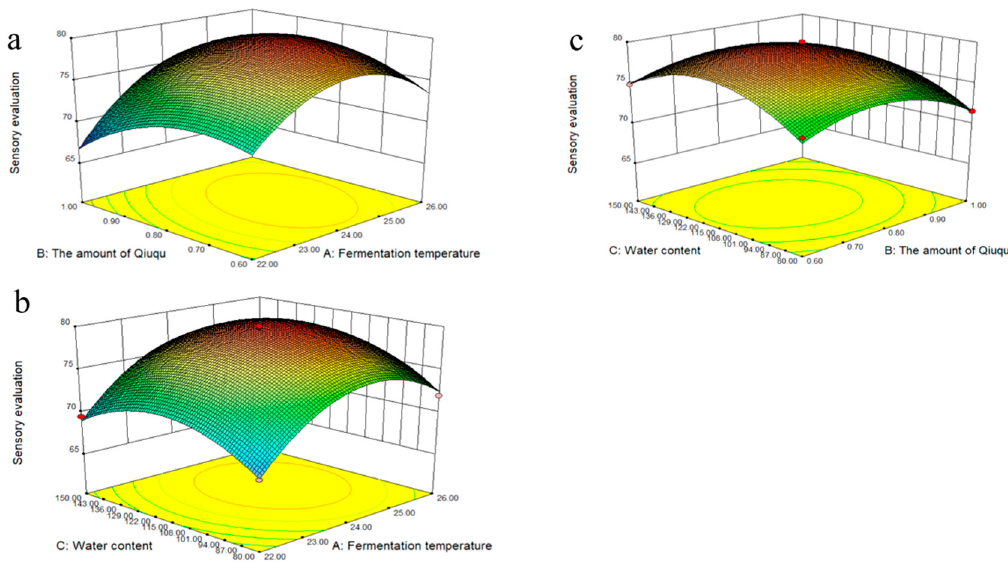
Figure 2. Response surface plot for sensory evaluation as a function of, ( a ) fermentation temperature and the amount of Qiuqu, ( b ) fermentation temperature and water content, and ( c ) water content and the amount of Qiuqu.